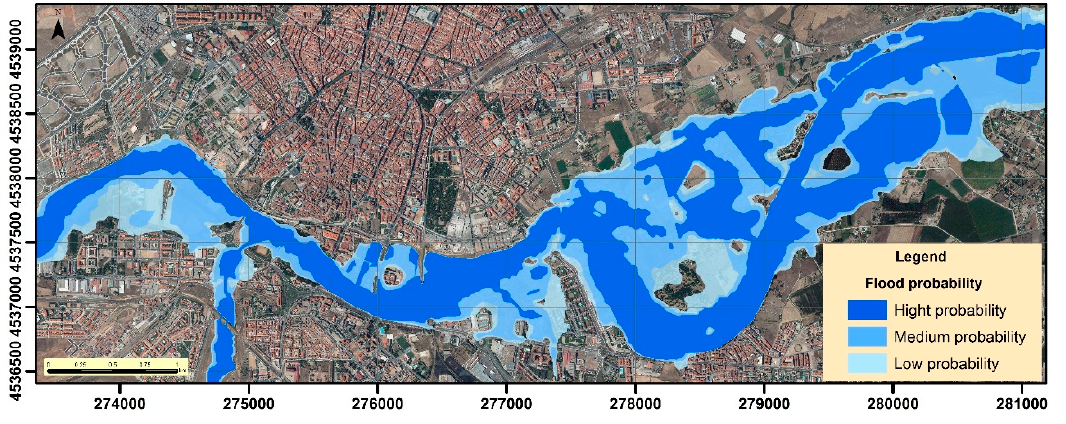
Figure 5. Magnitude of floods for each return period: ( A ) T = 5 years; ( B ) T = 100 years; and ( C ) T = 500 years.